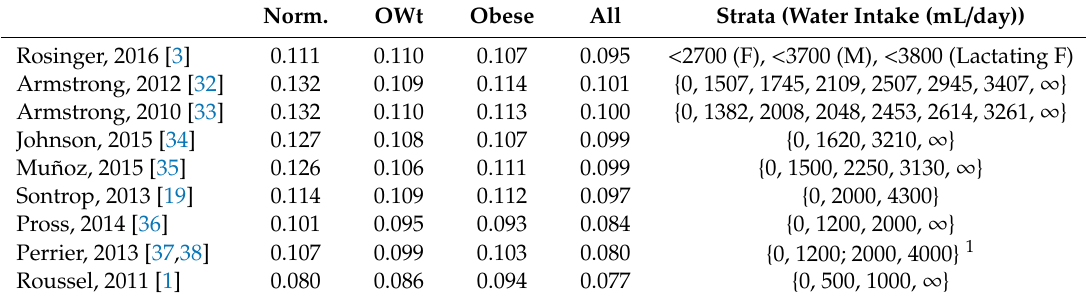
Table 1. Goodness of fit of Rosinger et al. with various water intake stratifications used in previous publications. Cells contain R 2 values obtained from regression models built from the published model. Top row is the replicated model from Rosinger et al.; all other rows use same dataset and same model as Rosinger et al., but with the altered stratification of a single variable (water intake). Some stratifications showed an improved goodness of fit (R 2 greater than Rosinger et al.); some stratifications showed a degraded goodness of fit (R 2 less than Rosinger et al.). All models showed a generally weak model fit (R 2 < 0.15). Norm. OWt Obese All Strata (Water Intake (mL / day)) Rosinger, 2016 [3] 0.111 0.110 0.107 0.095 < 2700 (F), < 3700 (M), < 3800 (Lactating F) Armstrong, 2012 [32] 0.132 0.109 0.114 0.101 {0, 1507, 1745, 2109, 2507, 2945, 3407, ∞ } Armstrong, 2010 [33] 0.132 0.110 0.113 0.100 {0, 1382, 2008, 2048, 2453, 2614, 3261, ∞ } Johnson, 2015 [34] 0.127 0.108 0.107 0.099 {0, 1620, 3210, ∞ } Muñoz, 2015 [35] 0.126 0.106 0.111 0.099 {0, 1500, 2250, 3130, ∞ } Sontrop, 2013 [19] 0.114 0.109 0.112 0.097 {0, 2000, 4300} Pross, 2014 [36] 0.101 0.095 0.093 0.084 {0, 1200, 2000, ∞ } Perrier, 2013 [37,38] 0.107 0.099 0.103 0.080 {0, 1200; 2000, 4000} 1 Roussel, 2011 [1] 0.080 0.086 0.094 0.077 {0, 500, 1000, ∞